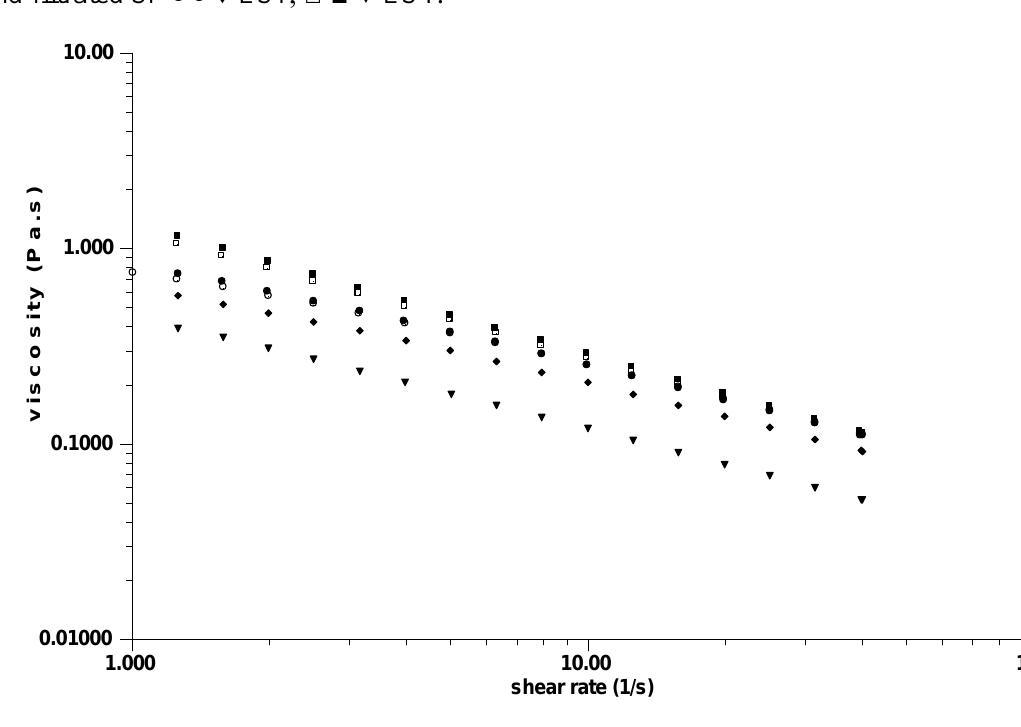
Figure 7. Comparison of the influence of filtration and centrifugation on viscosity, as a function of shear rate for two synovial fluids at 25 °C. Respectively: initial, centrifugated and filtrated SF ○● ♦ LS1; □ ■ 